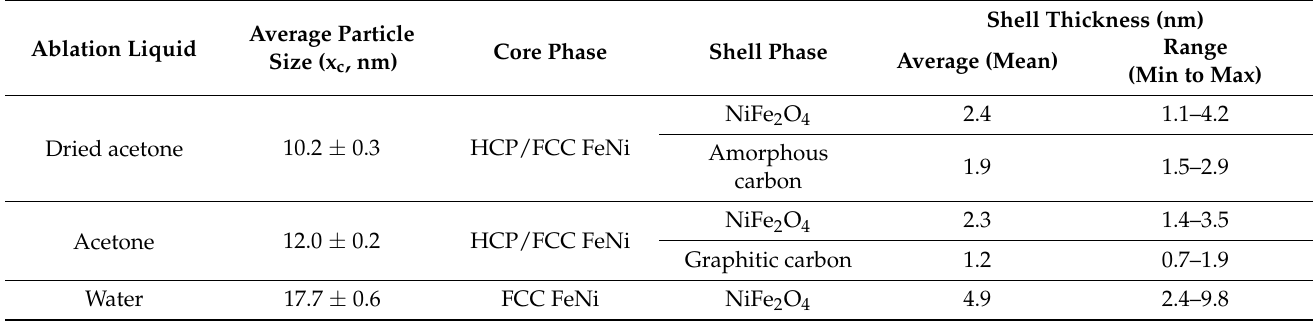
Table 2. FeNi NPs in dried acetone, acetone, and water shell thicknesses as obtained by